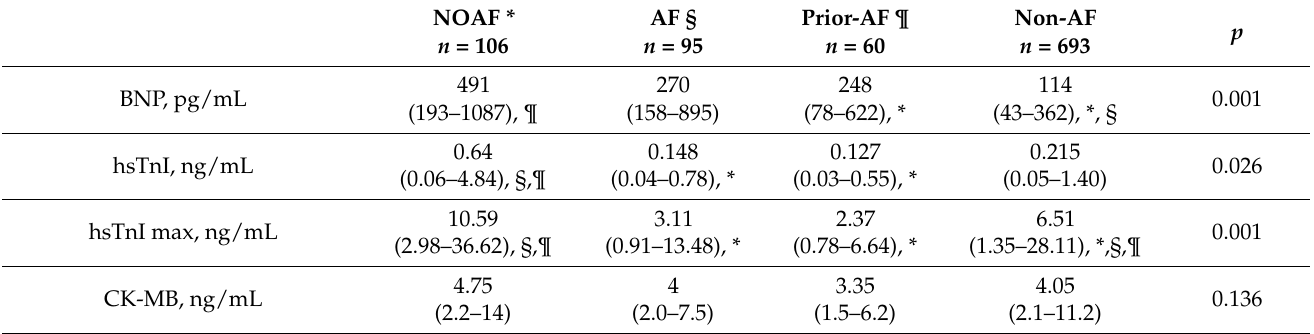
Table 3. Laboratory and echocardiographic parameters of the studied